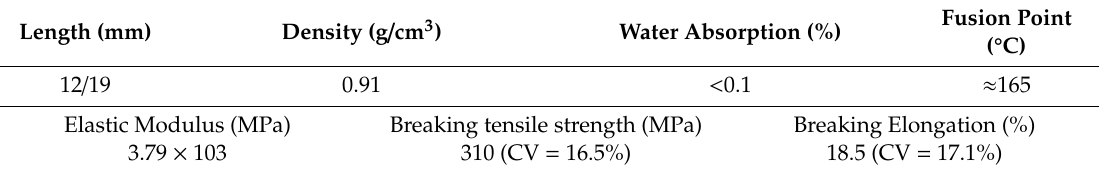
Table 1. Physical and mechanical properties of the waste polypropylene fiber.